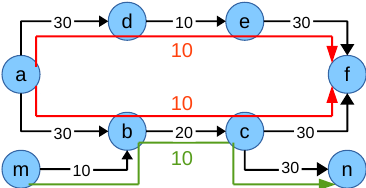
Figure 11. Example scenario for NFF with optimum allocation. Black arrows/numbers: links with capacities, colored arrows/numbers: flows with capacity assignments. All values in Mbps.